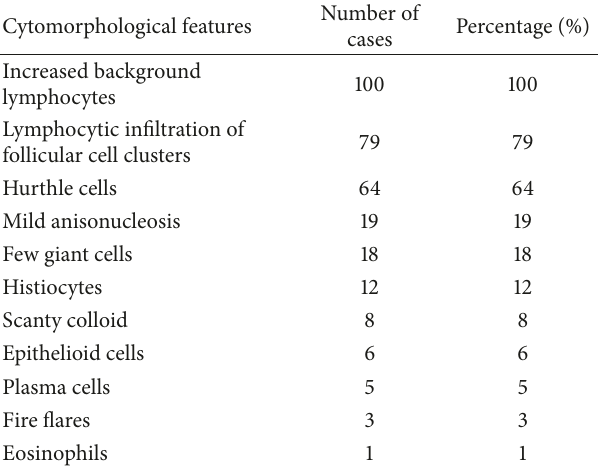
Table 2: Frequency of various cytological features in Hashimoto’s